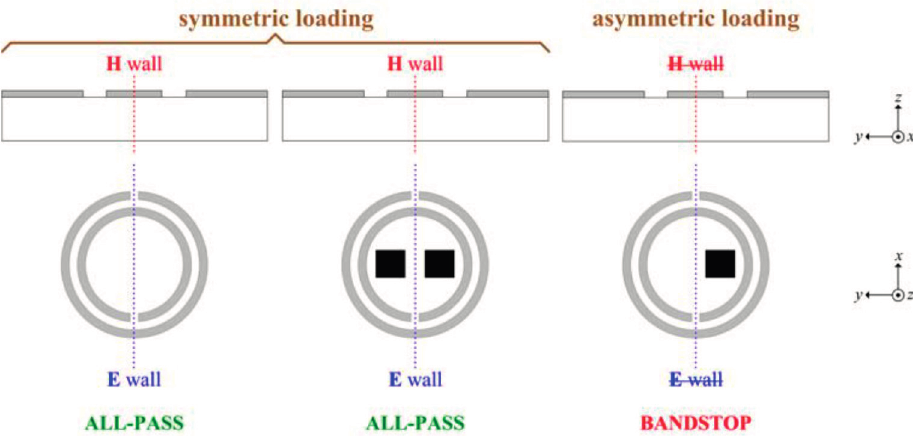
Figure 3. Illustration of symmetry rupture by square-shaped inclusions in the approach based on a single resonator, where a CPW is loaded with a symmetrically oriented